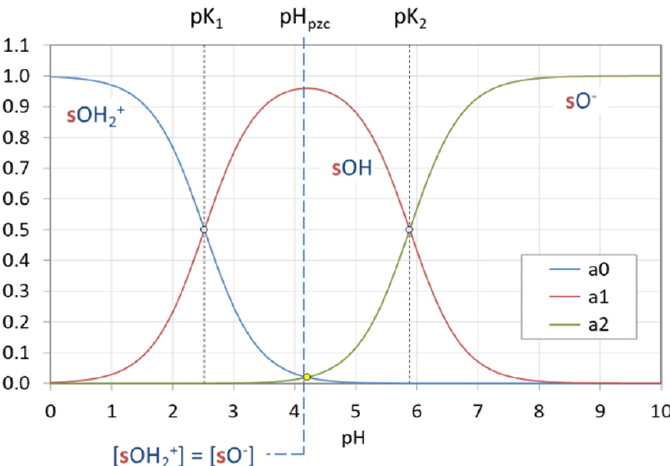
Figure 42. Ionization fractions representing the surface-species distribution on kaolinite (in the absence of Coulomb interactions).